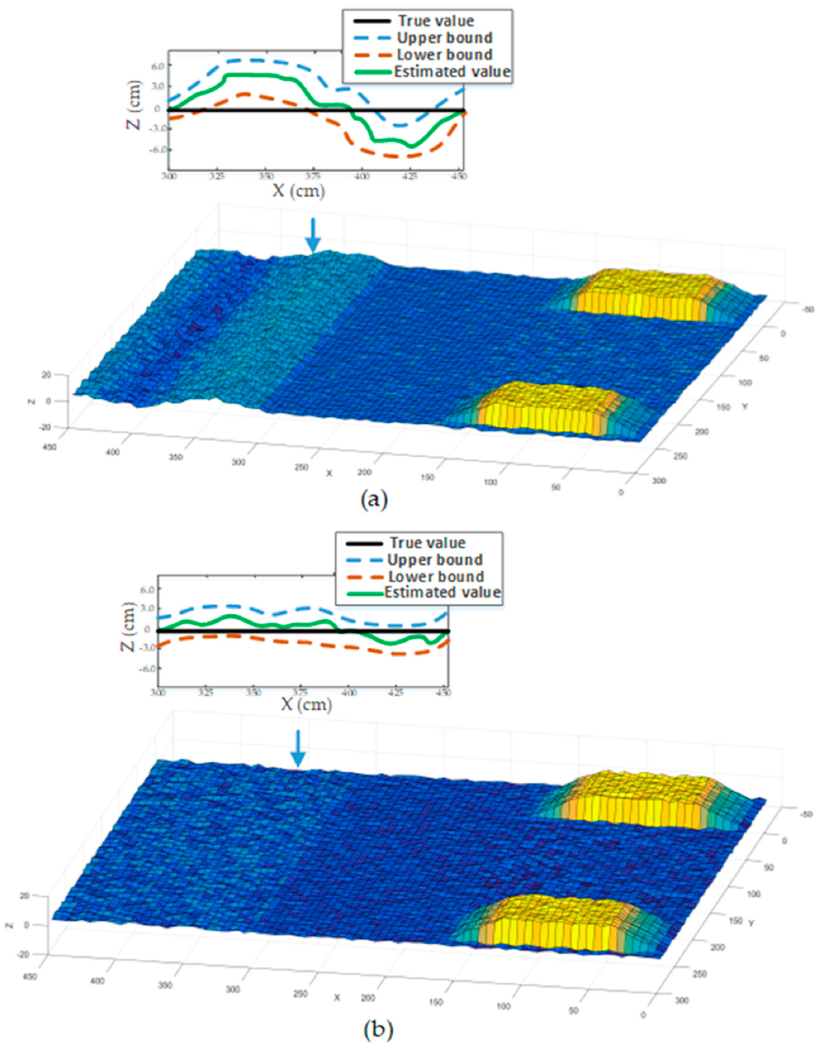
Figure 10. Estimated terrain elevation map. ( a ) Obtained terrain elevation map in passive suspension mode. ( b ) Obtained terrain elevation map in active suspension mode.